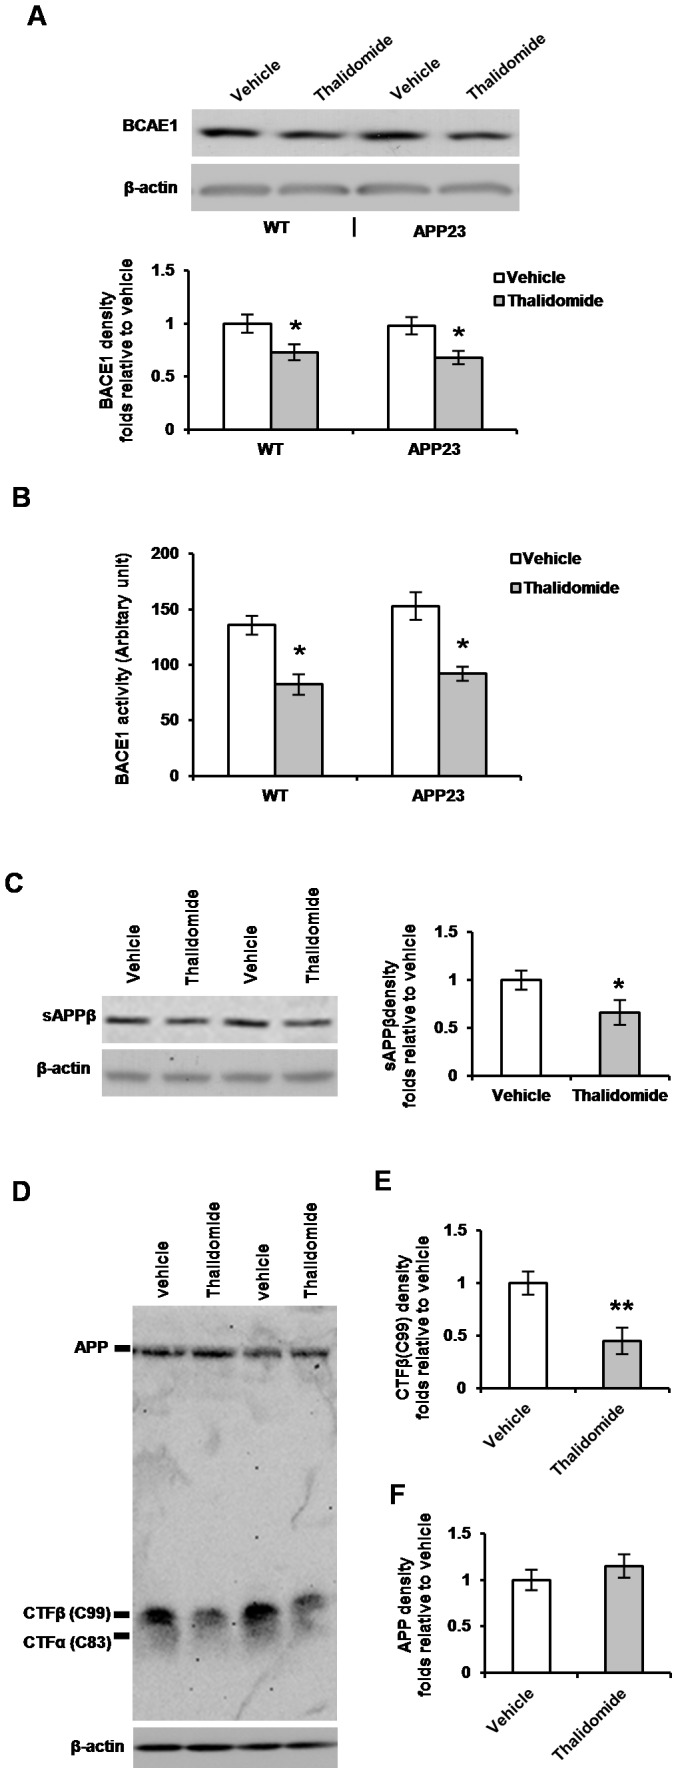
Thalidomide lowers BACE1 and reduces β-site cleavage of APP.Representative images of Western blots showed β-secretase enzyme BACE1 bands in WT and littermate APP23 mice with/without thalidomide administration (A) and a significant decrease in BACE1 amount was found with thalidomide application (A, Mean ± SD, *p<0.05, ANOVA test, n = 10 each group). BACE1 activity was normalized to the input protein amount and indicated as an arbitrary unit. The activity was measured and a lower activity of BACE1 was found with thalidomide application (B, Mean ± SD, *p<0.05, ANOVA test, n = 10 each group). Representative images of Western blots showed an amount decrease of sAPPβ secretion (C) and the density of bands significantly reduced in the thalidomide treated APP23 mice compared to littermate vehicle groups (C, Mean ± SD, *p<0.05, Students t-test, n = 10 each group). Microphotographic images of APP-CTF fragments showed an amount decrease of C99 following thalidomide administration (D). The density of bands was measured with a significant decrease in C99 fragments (E) but not significant changes of APP levels compared to vehicle groups (F) (Mean ± SD, **p<0.01, Students t-test, n = 10 each group).